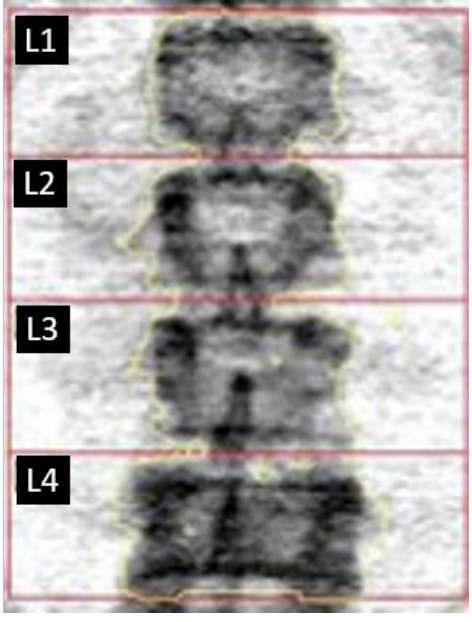
Figure 3. Densitometric image of the lumbar spine.